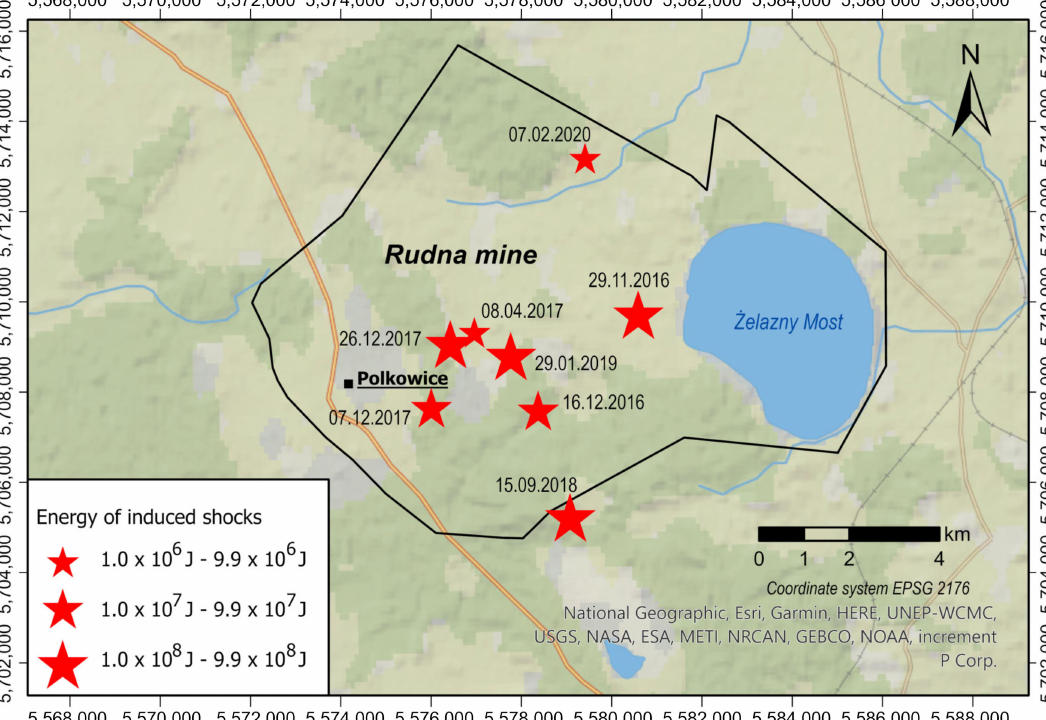
Figure 4. Location and date of the 8 analyzed induced